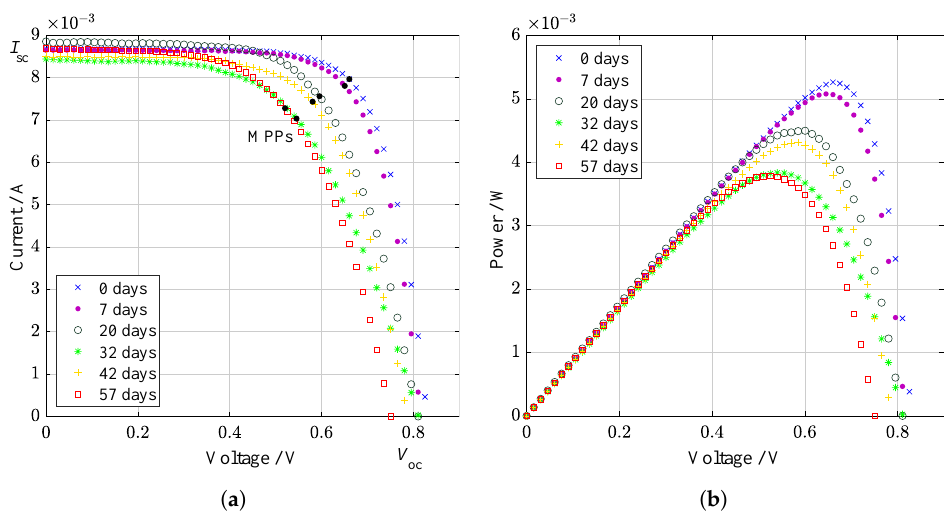
Figure 11. ( a ) Light I–V curves and recalculated ( b ) power characteristics of GaAs specimen under supercontinuum laser processing. Maximum power points (MPPs) are marked. On day 42, efficiency improvements can be seen [73]. Table 3. Electrical parameters from light I–V measurements of the PV cell during the supercontinuum laser processing